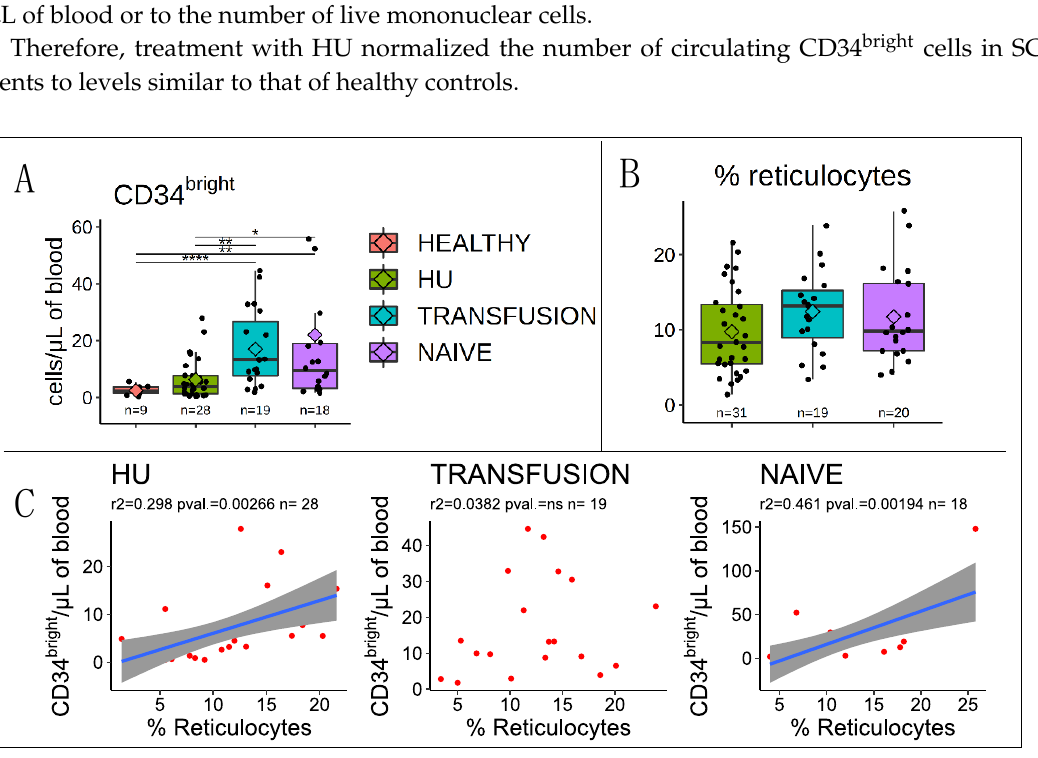
Figure 2. CD34 bright cells are elevated in transfusion and naive groups: ( A ) CD34 bright cells: Boxplot illustrates the concentration of CD34 bright cells per mL of blood. Boxplots and significance are as in Figure 1. All three groups of SCD patients exhibit higher mean concentration of CD34 bright than healthy individuals, but in the HU group, the average concentration of CD34 bright cells is lower than in the other two groups and much closer to that of healthy individuals. ( B ) Boxplot illustrates the percentage of reticulocytes in patients with SCD. The reticulocyte percentages in all three groups of SCD patients averages 10 to 15%, much higher than the normal range, suggesting that regardless of treatment, erythropoiesis is not completely normalized and is higher in SCD patients than in healthy individuals. ( C ) Plots illustrating a regression analysis between the concentration of CD34 bright cells in the blood and the percentage of reticulocytes. * p ≤ 0.05; ** p ≤ 0.01; **** p ≤ 0.0001.